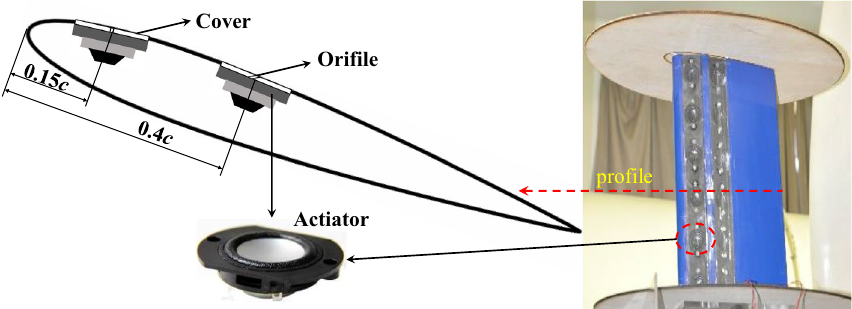
Figure 1. Pictorial configurations of the SJAs and their placements in the